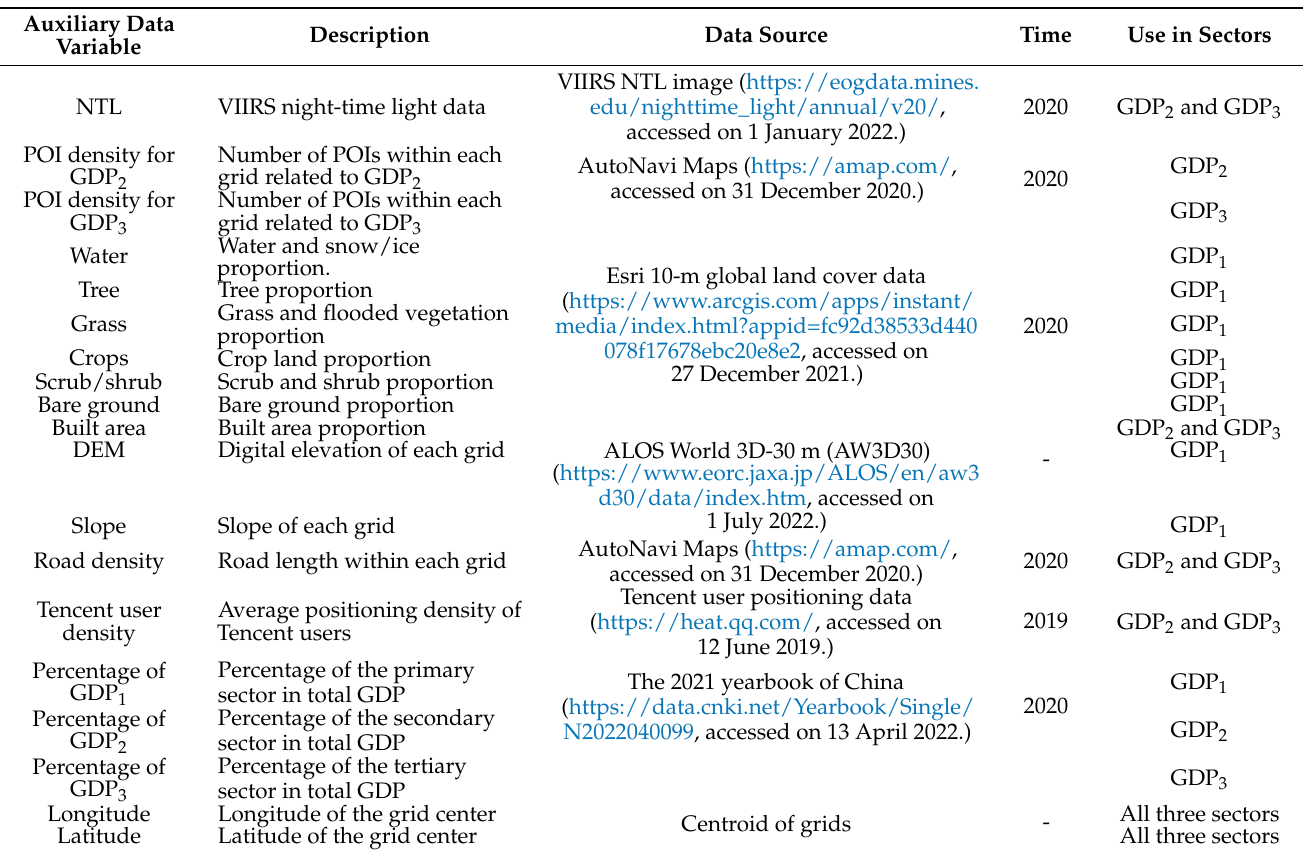
Table 1. Covariates for the GDP downscaling of